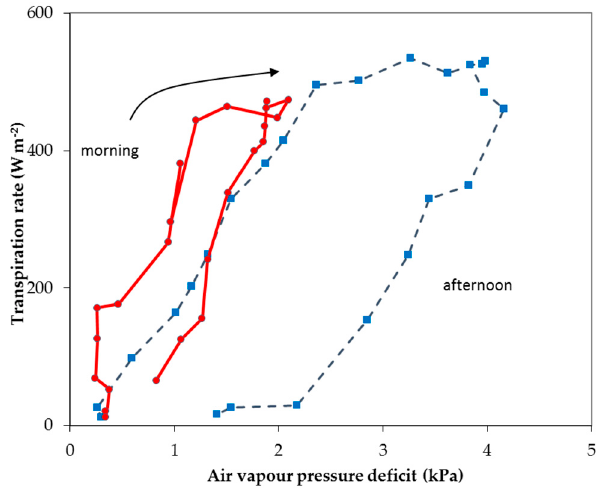
Figure 1. Canopy transpiration rate ( λ ET ) versus air vapor pressure deficit under misting (continuous line) or no misting (dotted line) conditions in a naturally ventilated greenhouse, as presented by the authors of [24].